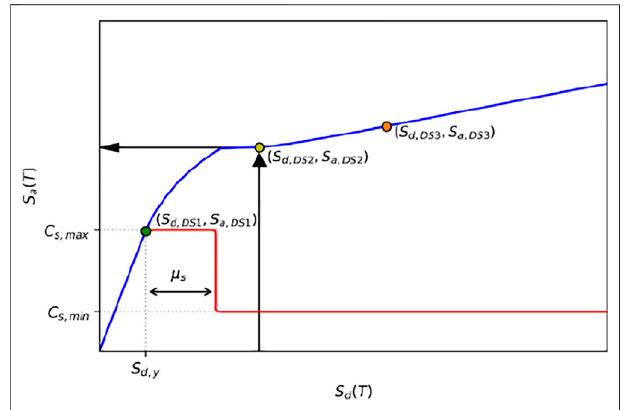
FIGURE 2 | Capacity curve (red), approximate IDA curve (blue), and damage thresholds for DS1 (green circle), DS2 (yellow circle), and DS3 (orangecircle)represented intheS d (T)-S a (T)planeused intheFAST method.